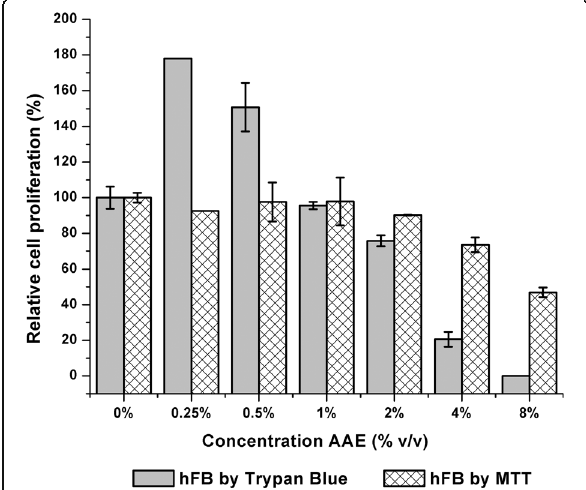
Fig. 5 Comparative of relative cell proliferation percentage of hFB cell line in the aqueous extract (AAE) by MTT and Trypan blue test. Error bars represent standard